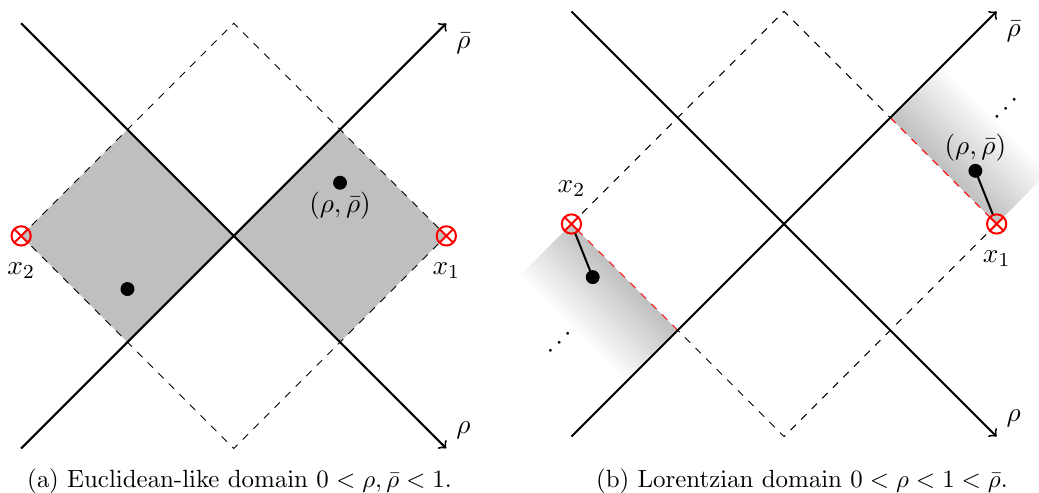
Figure 2. Domains in Lorentzian kinematics. The spherical defect intersects the ( (cid:26); (cid:22) (cid:26) )-plane at x 1 and x 2 . In order to pass from the Euclidean-like region a (depicted in gray) to the Lorentzian region b, we need to cross two light-cones, once of x 1 and once of x 2 . Time-like distances are depicted by a bold